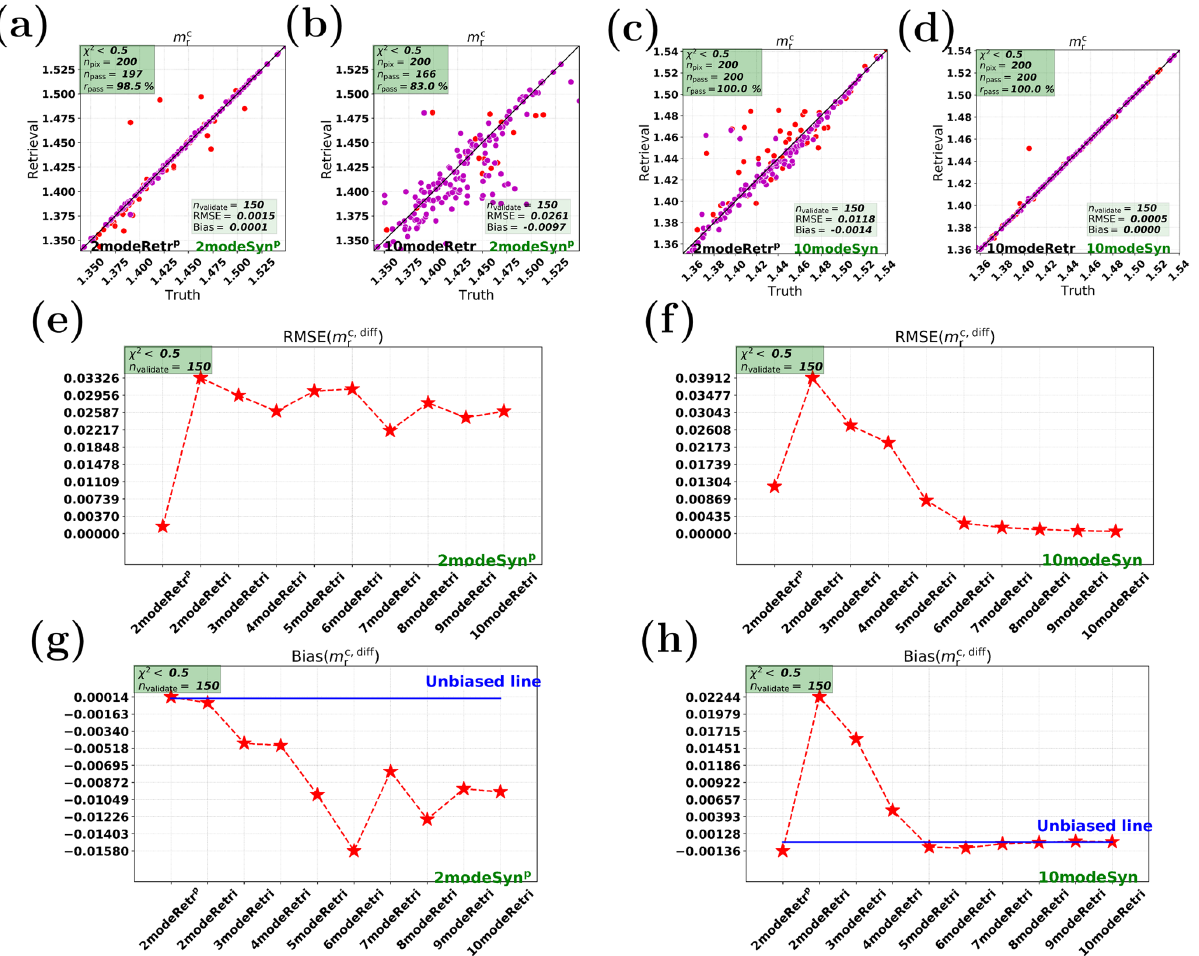
Figure 8. Synthetic retrievals for the real part of refractive index (at 550nm) of the coarse modes ( m c r ). Panels (a, b, e, g) and (c, d, f, h) show cases on 2modeSyn p and 10modeSyn,